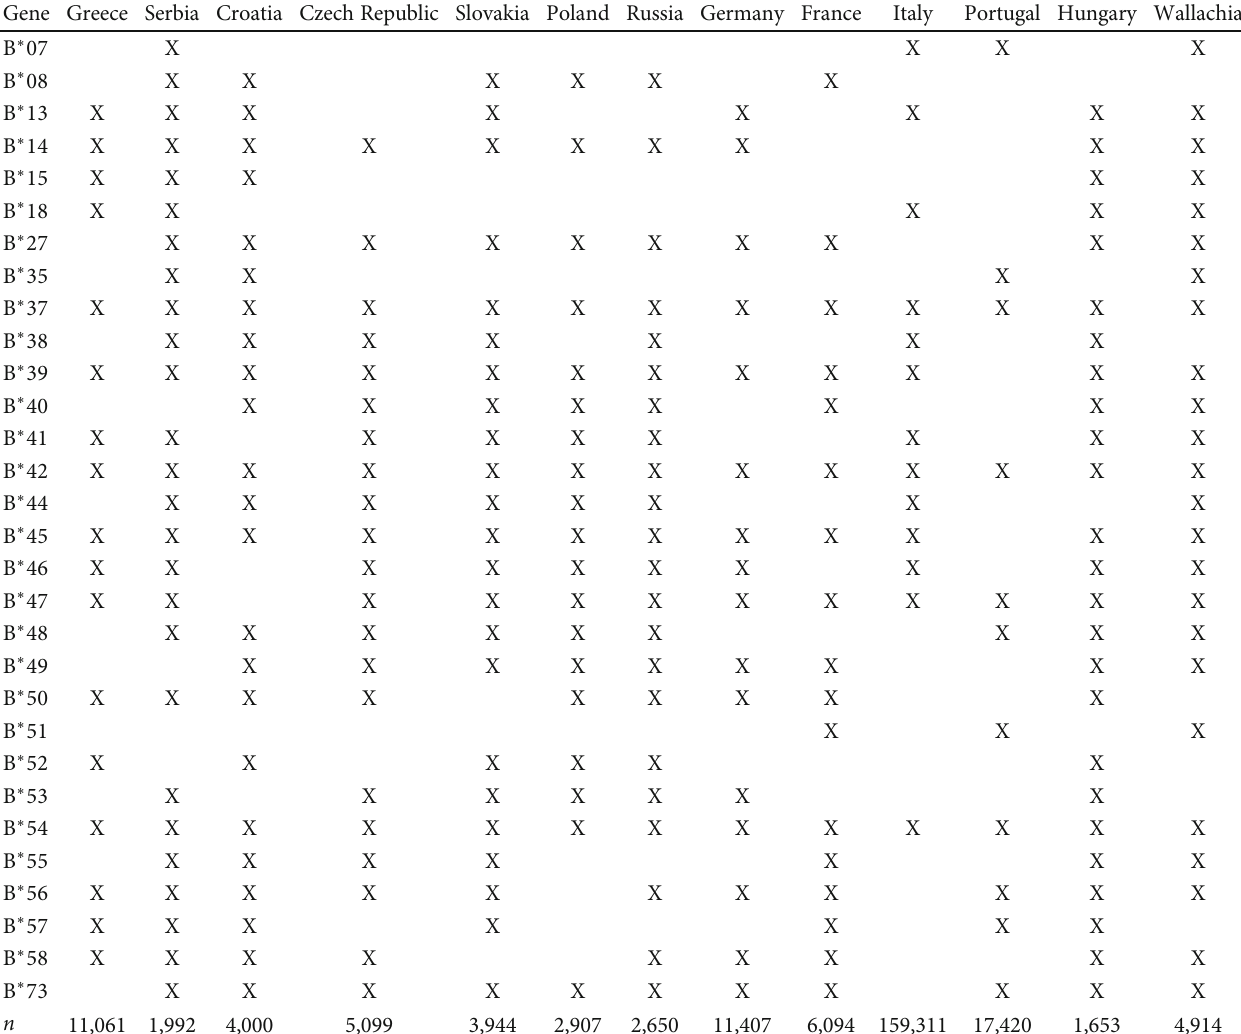
Table 5: Comparison of HLA-B gene frequencies in the Transylvanian ( n = 2,773 ) vs. other European population